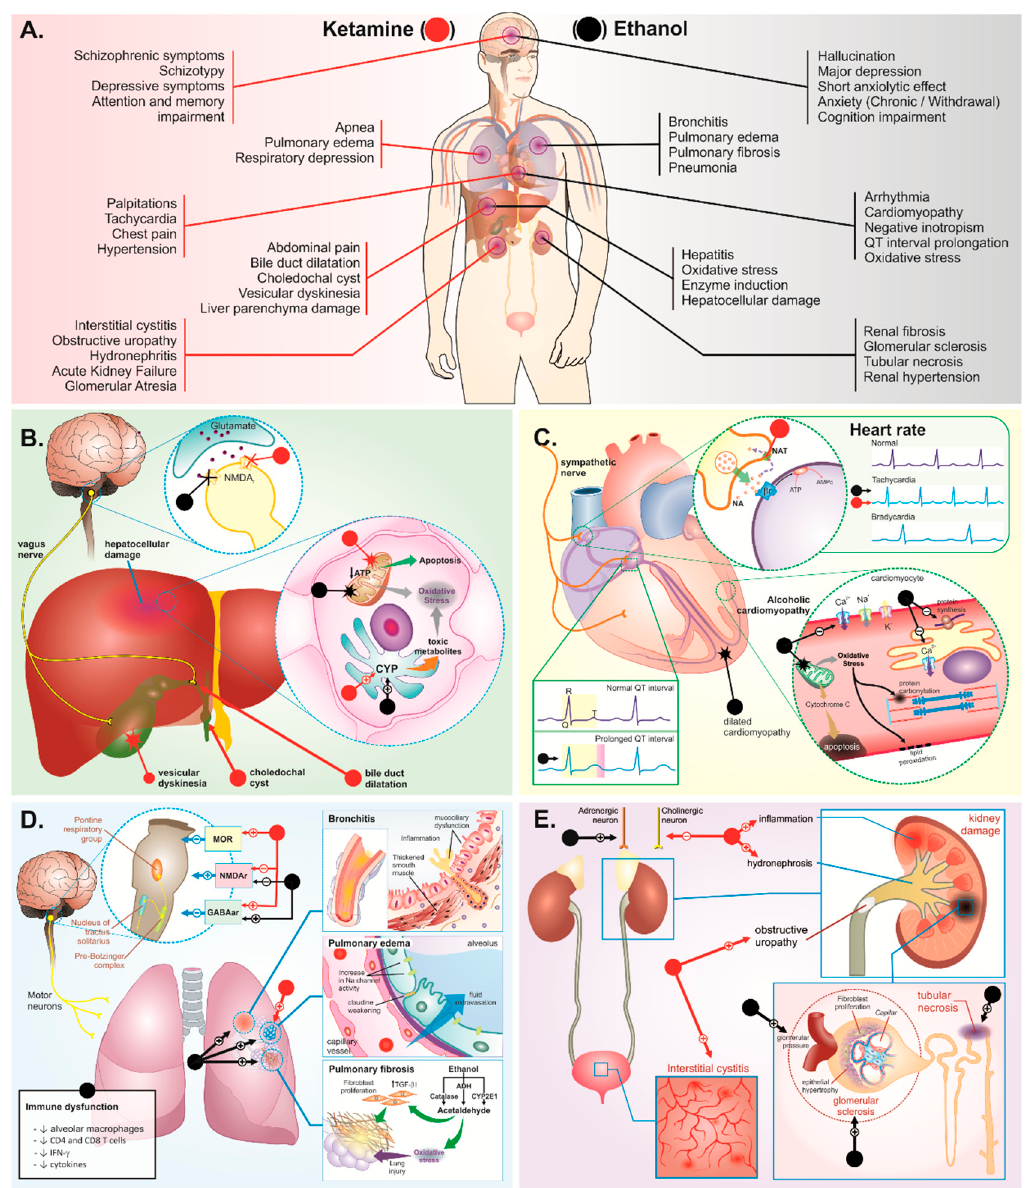
Figure 1. Schematic pharmacological targets with potential synergism between deleterious effects of ketamine (red markers) and ethanol (black markers), highlighting ( A ) the main clinical manifestations already described and effects related to ( B ) hepatic, ( C ) cardiac, ( D ) respiratory, and ( E ) urinary damage. (+) Activation, elevation, potentiation, or stimulation; ( − ) inhibition or reduction; (X) blocking; ( ) damage or disruption.